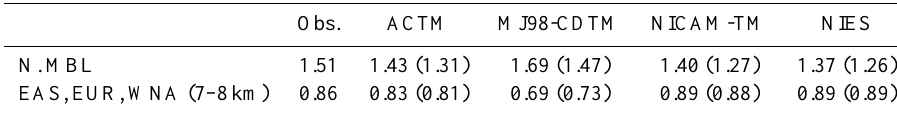
Table 6. Ratios of seasonal amplitudes to that at 4–5km in the northern area for 2007. Simulated results are derived using Flux2 and Flux1 (parenthetical values).